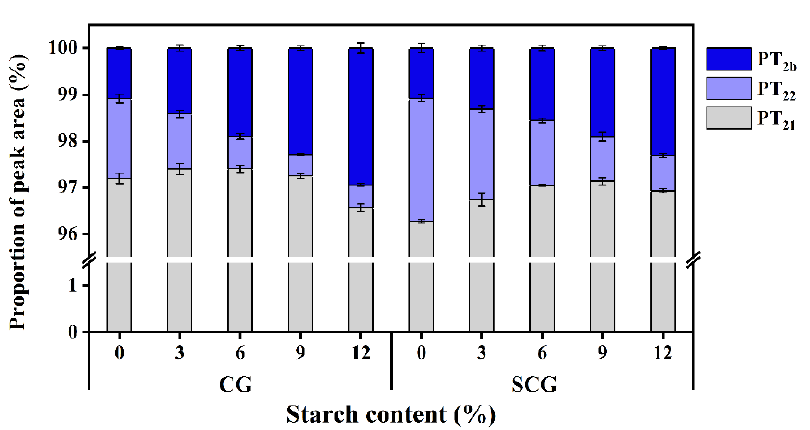
Figure 2. Peak area proportion (P T2b , P T21 , and P T22 ) of different water in starch – surimi matrix subjected to direct heating and two-step heating. Caption: see Figure 1.